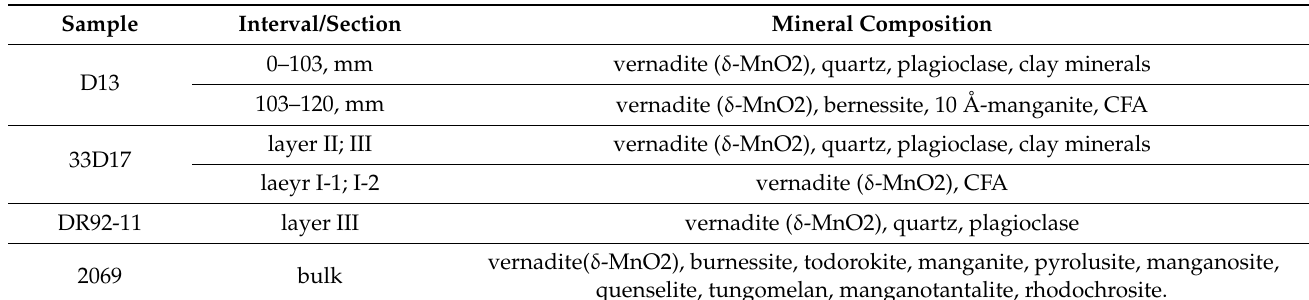
Table 2. Mineral composition of ferromanganese crusts.